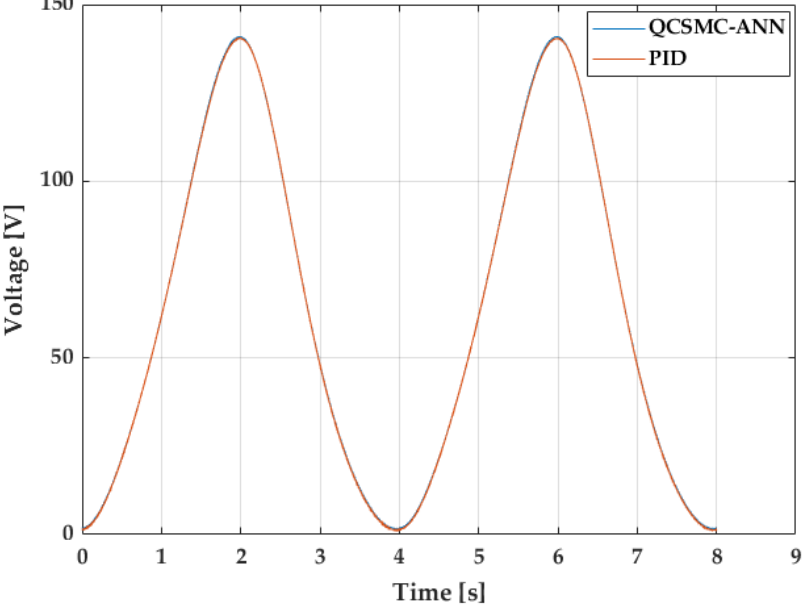
Figure 9. The control signal in 2 cycles of a sine wave